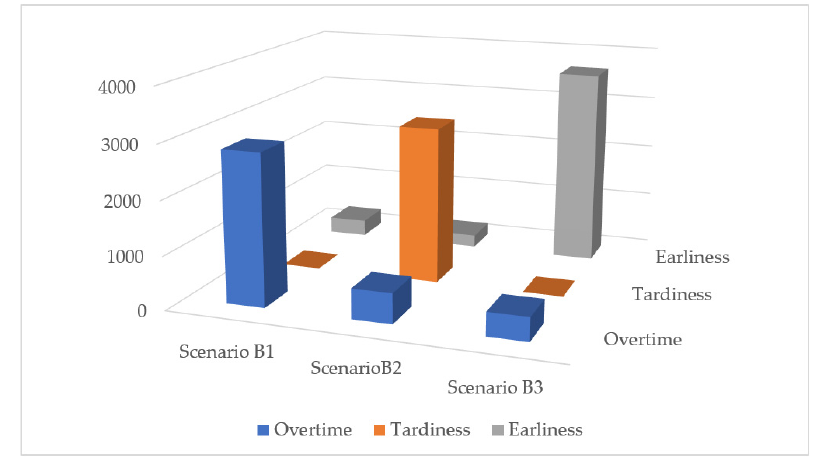
Figure 13. The comparison among Scenario B1, B2, and B3.